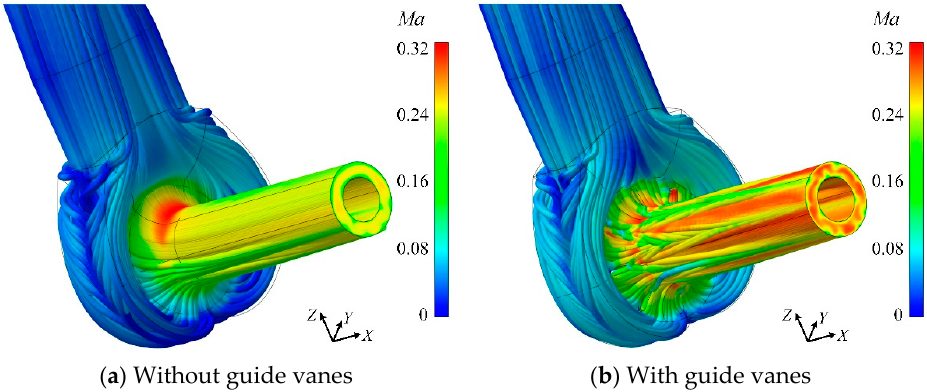
Figure 9. Three-dimensional streamlines inside the radial inlet chambers.